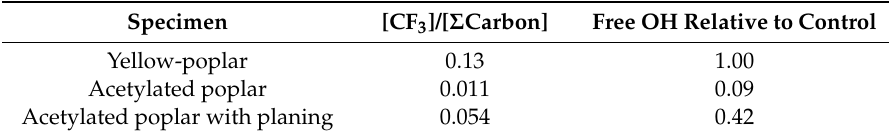
Table 1. Relative amount of free surface hydroxyls by trifluoroacetylation of